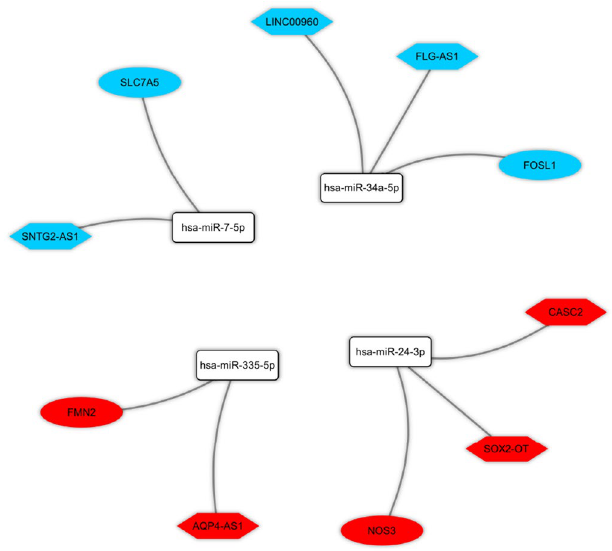
Figure 4. The long non-coding RNA-associated competing endogenous RNA (ceRNA) axes in OE in schizophrenia. The red and blue nodes represent the upregulation and downregulation, respectively. Gray edges represent interactions between RNAs. LncRNAs, miRNAs, and mRNAs are represented by hexagon, round rectangle, and ellipse,